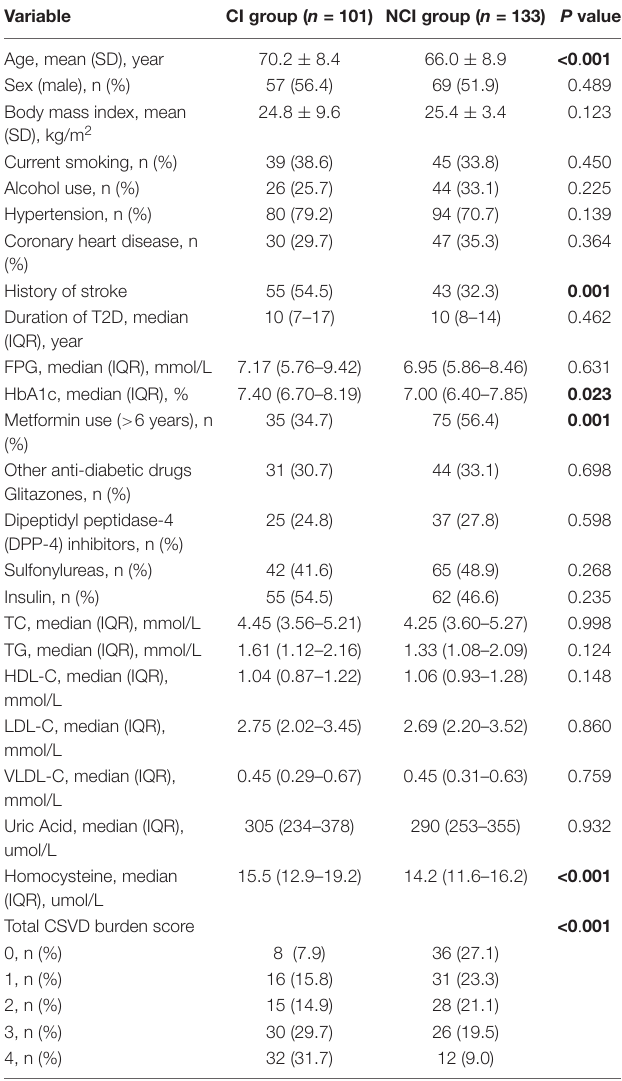
TABLE 1 | Characteristics of the study participants between CI and NCI